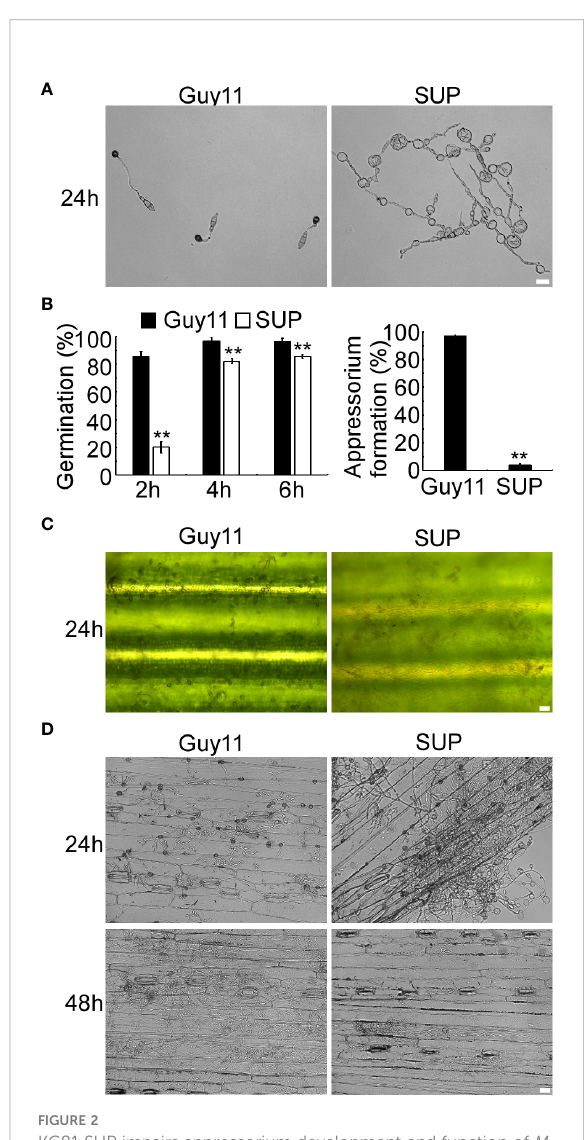
FIGURE 2 KC81 SUP impairs appressorium development and function of M. oryzae . (A) Appressorium formation assay on hydrophobic surfaces. Conidia were incubated on hydrophobic surfaces and the samples were observed. (B) Statistical analysis of spore germination rates and appressorium formation rates at different time points. The percentage at a given time was recorded by observing at least 100 conidia for each strain and the experiment was repeated thrice. Error bars represent SD and two asterisks represent signi fi cant differences ( p < 0.01). (C)